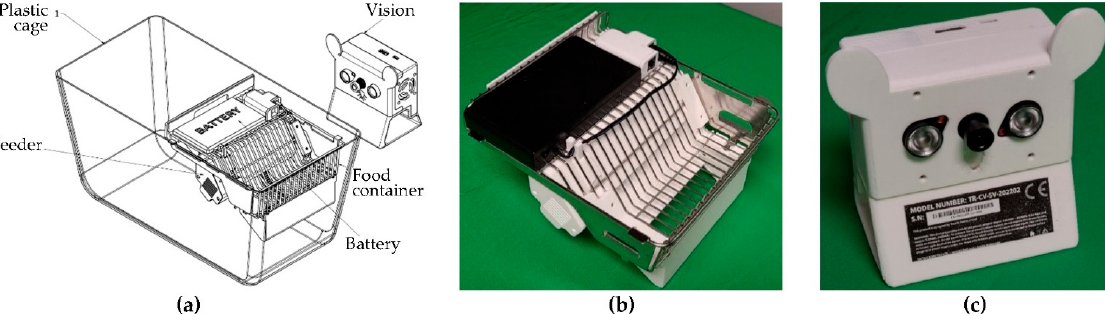
Figure 2. ( a ) Overall scheme of the apparatus that consists of the plastic frame, feeding mechanism, vision unit, food container, and power system. ( b ) Feeding mechanism and ( c ) vision unit mounted on and placed next to the mouse cage, respectively.